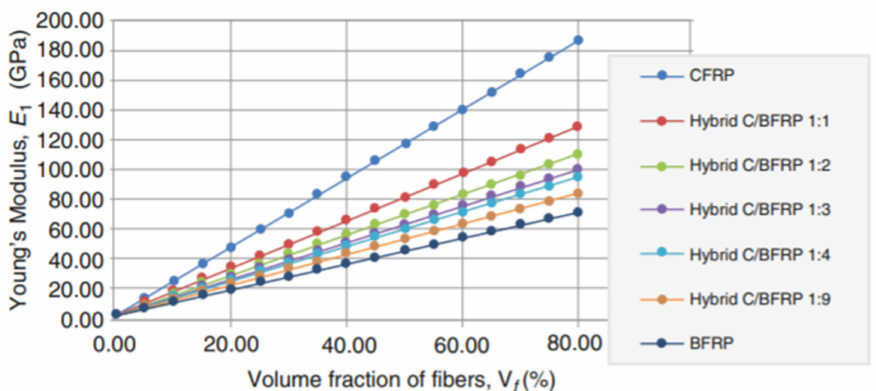
Figure 1. Theoretical relationship of fiber volume fraction and Young (cid:48) s modulus (obtained from Voigt’s Model) for Hybrid Carbon / Basalt FRP